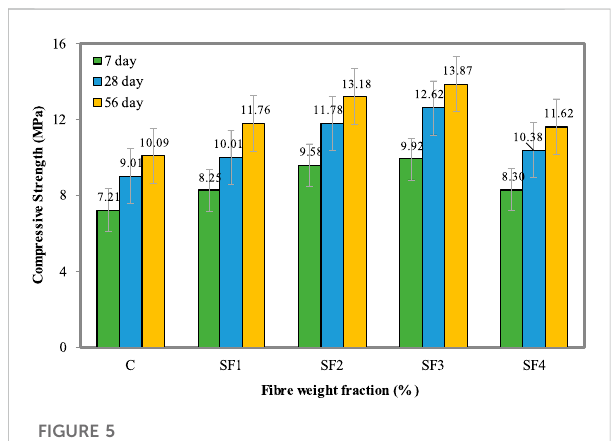
FIGURE 5 Compressive strength of 1,300 kg/m 3 FC density with varying weight fractions of SF.